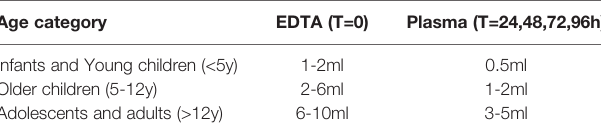
Thevolumeofbloodobtained(forbothchildrenandadults)willbedocumentedatthetime ofrecruitment andsampling. Consent willbe soughtto use residualEDTA samples forthe evaluation of emerging, rapid methods of bacterial detection and antimicrobial resistance identi fi